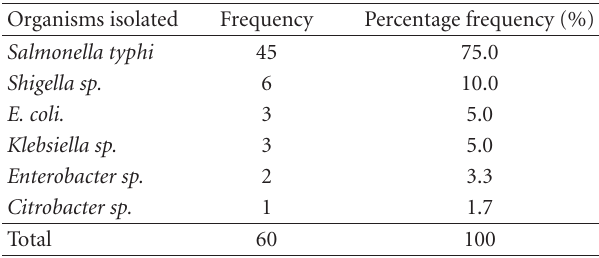
Table 1: Frequency of occurrence of Bacterial